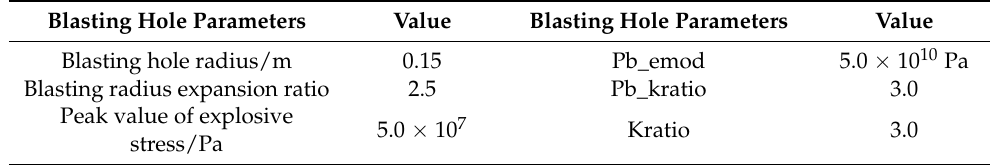
Table 5. Table of parameters of blasting holes.